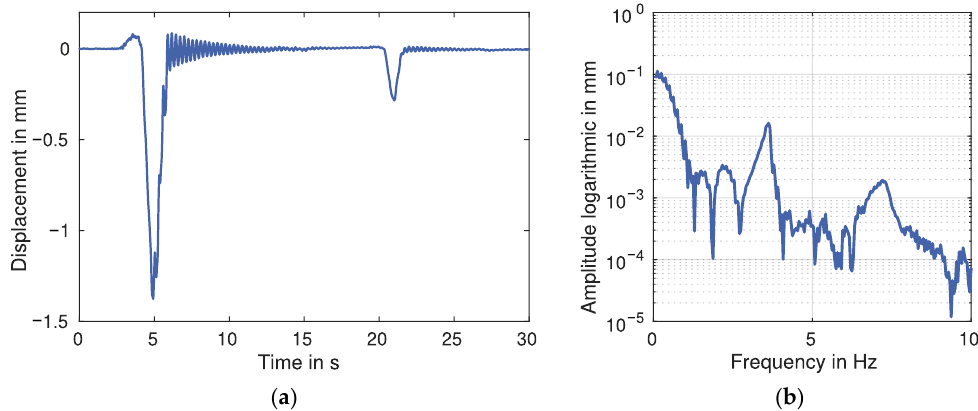
−− Figure 3. Example of vehicle crossings in the time and frequency domain: ( a ) Bridge displacement in the time domain. ( b ) Amplitude spectrum of the bridge